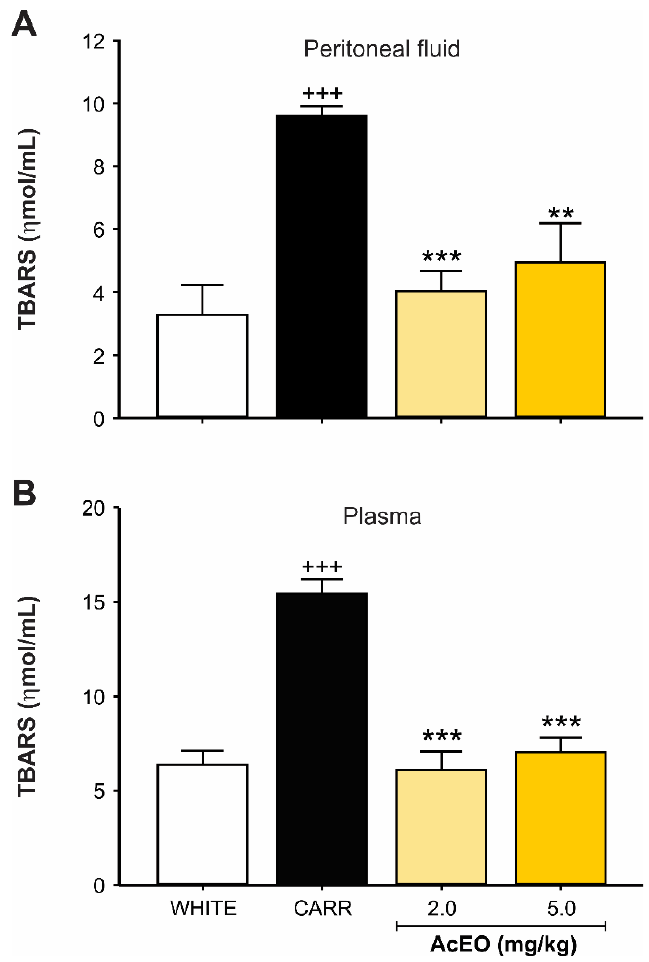
Figure 5. Effect of Aniba canelilla essential oil (AcEO; 2.0 and 5.0 mg/kg; ip.) on thiobarbituric acid reactive substances (TBARS) level in ( A ) peritoneal fluid and ( B ) plasma of rats submitted to carrageenan (CARR)-induced (0.3 mg/kg) peritonitis. Data expressed as mean ± SEM ( n = 5–6/group). +++ p < 0.001 vs. white group; ** p < 0.001 vs. CARR group; *** p < 0.001 vs. CARR group. One-way ANOVA followed by Dunnett’s test.